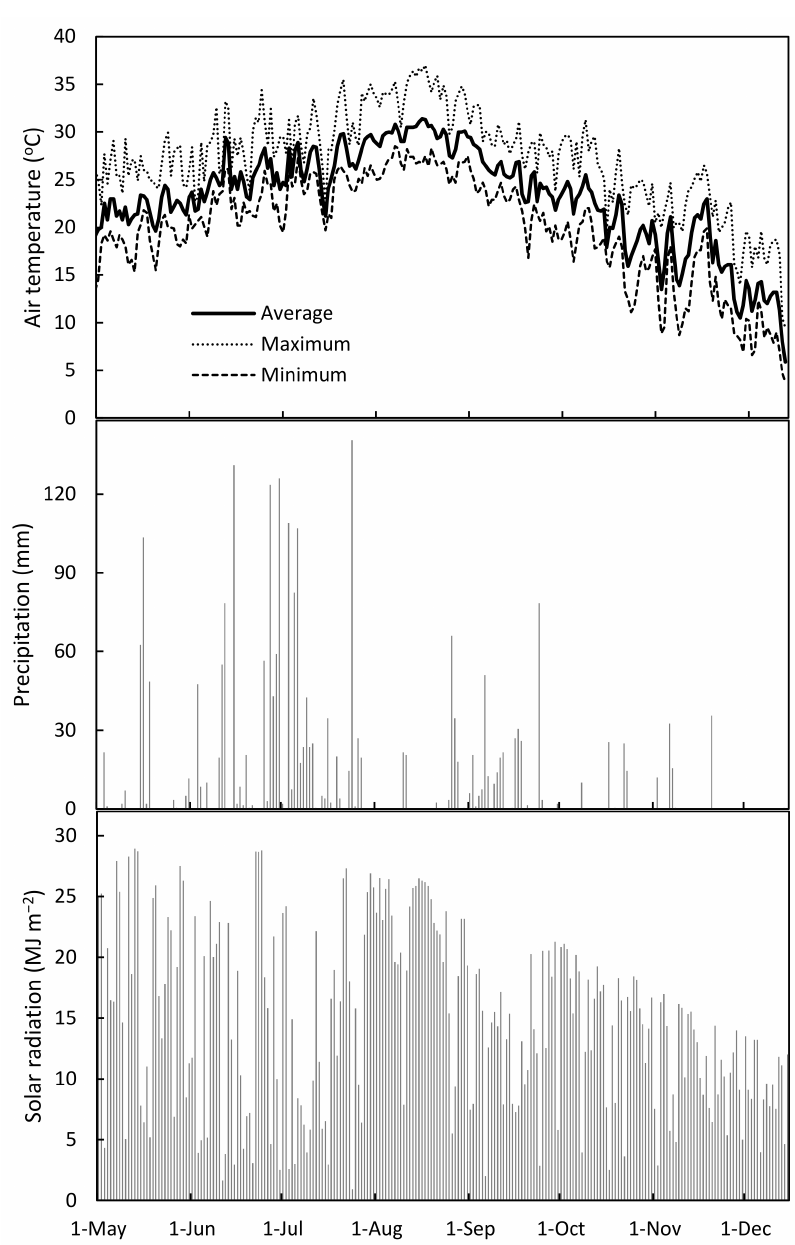
Figure 1. Minimum, maximum, and average air temperatures, daily precipitation, and solar radiation in the experiment